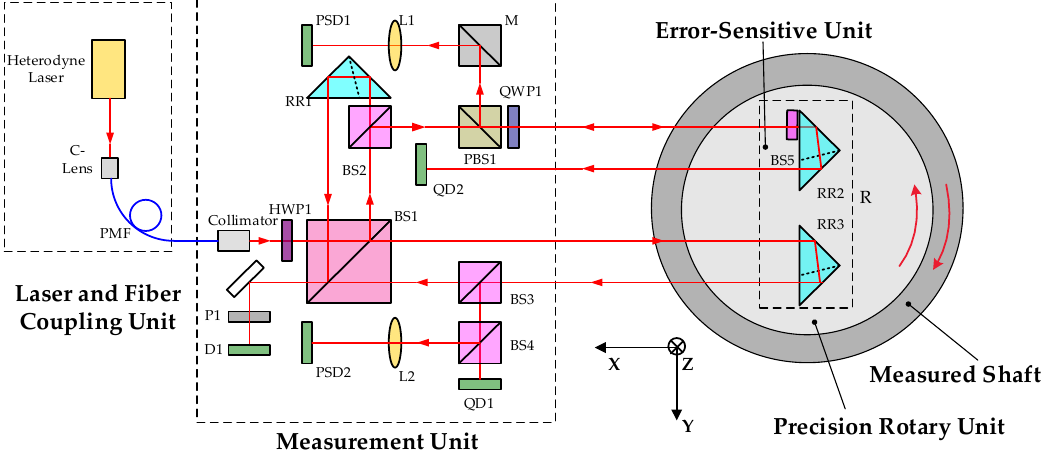
Figure 1. Measurement principle.